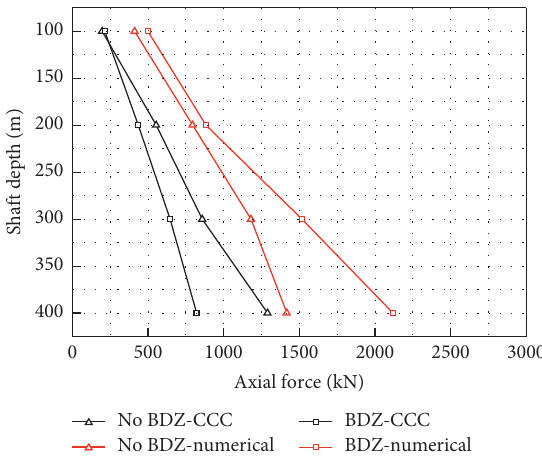
Figure 16: Maximum axial force versus depth as estimated using different analysis